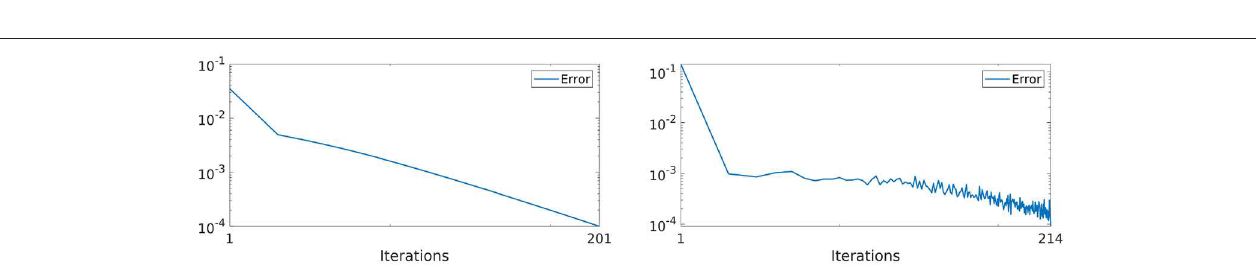
FIGURE 1 | Top : Evolution of the free dynamics of the Kuramoto model [Equation (5)] with N Kuramoto model [Equation (5)] with N